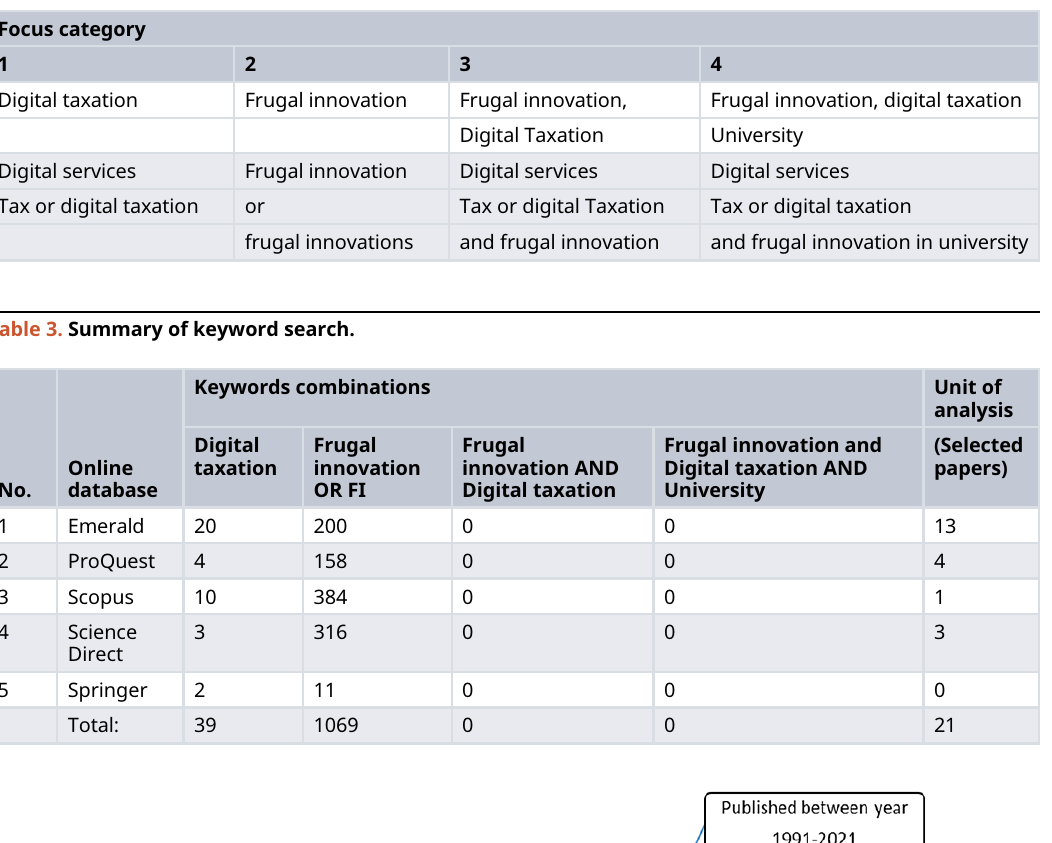
Table 2. Selected